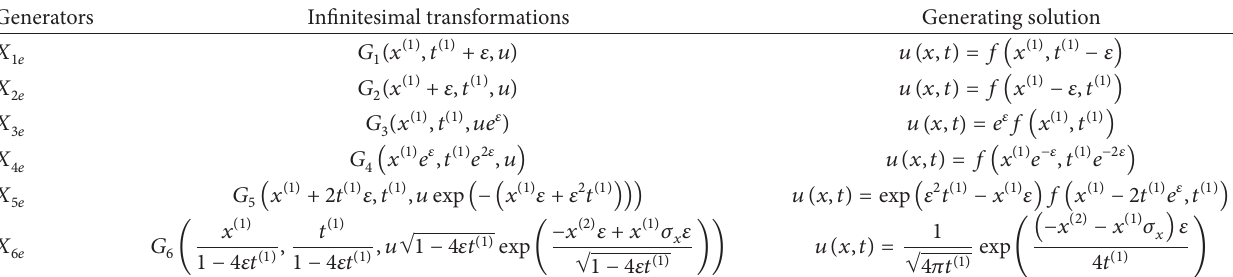
Table 4: Generating solutions for free heat